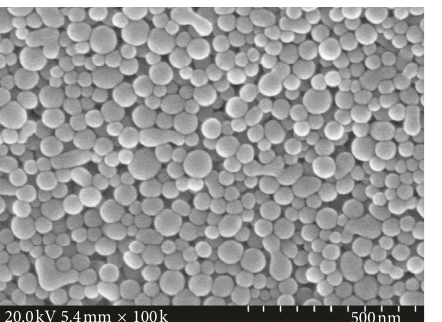
20.0kV 5.4mm × 100k Figure 3: SEM micrograph of functionalized silica nanoparticles.